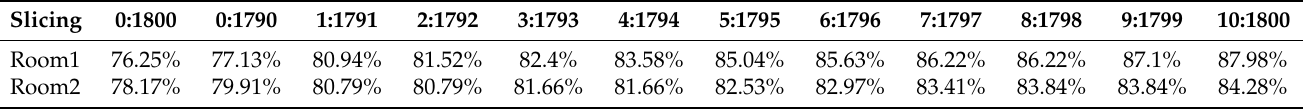
Table 5. The new data is used to continue training on the existing model, and the recognition accuracy is improved. Slicing